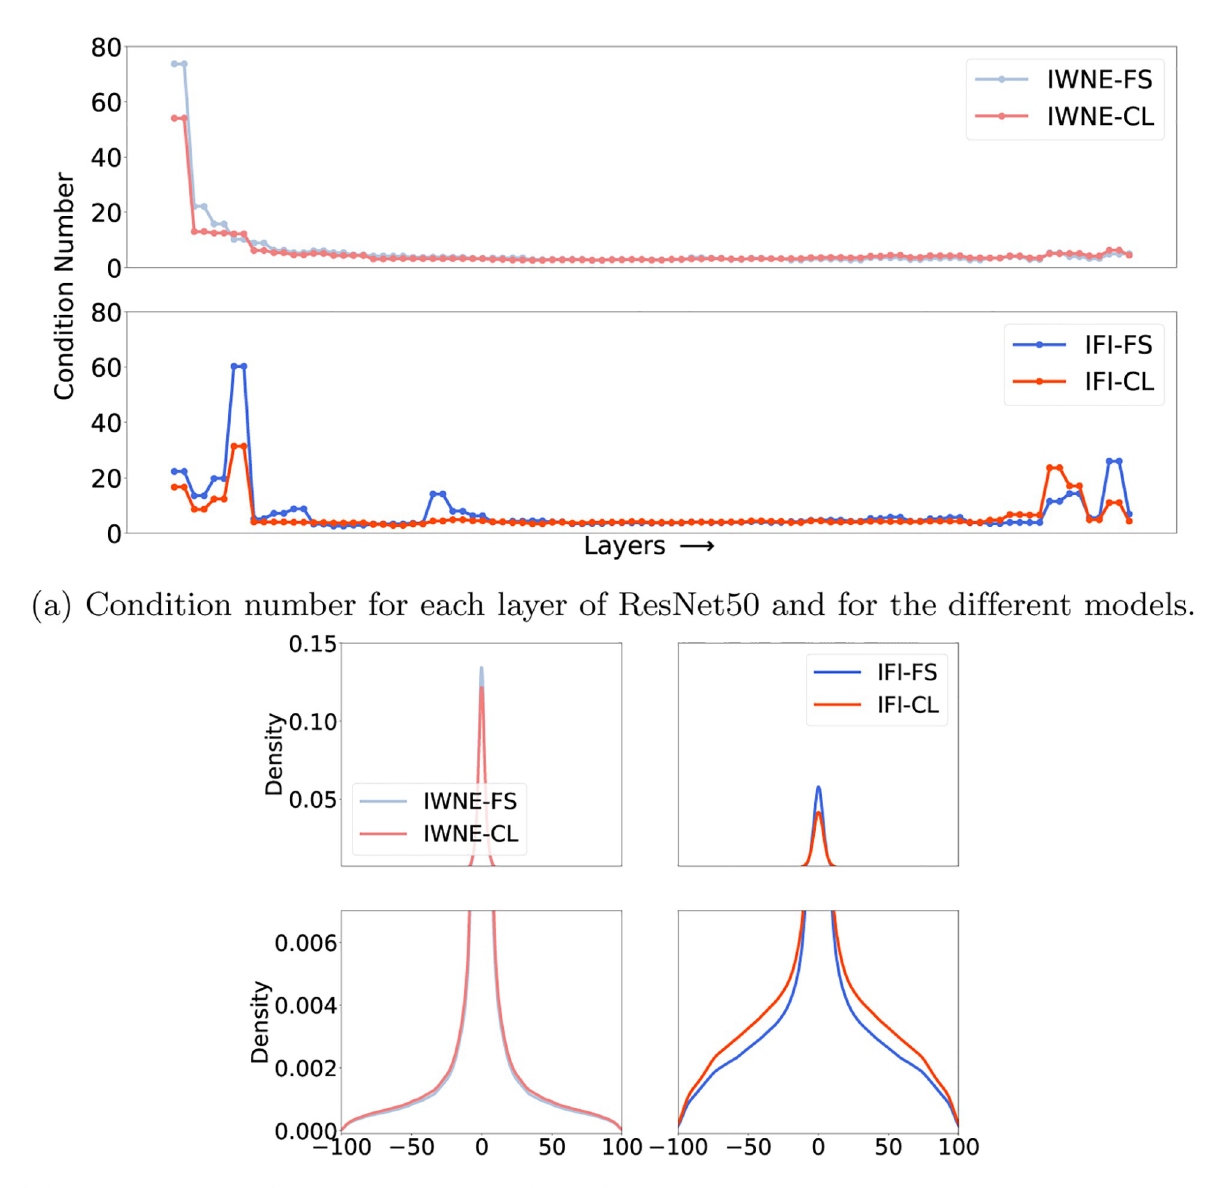
Fig 3. The statistics of the eigenvalues are shown here. a) shows the condition number of all the layers and b) shows the eigenvalues of the activations of the first convolutional layer. (a) Condition number for each layer of ResNet50 and for the different models. (b) Eigenvalues of the activations of the first convolutional layer made symmetrical around 0 and plotted in the form of density for better visualization.